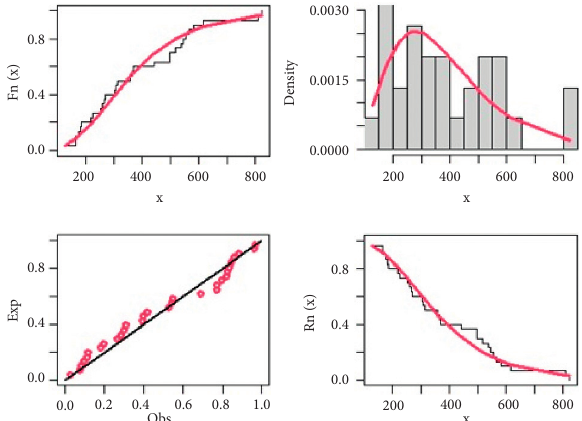
Figure 10: Plots of density, CDF, and survival of the GED for data set 1.